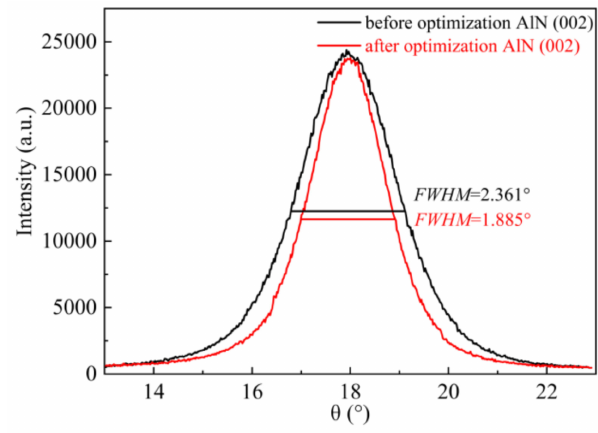
Figure 9. Swing curve of the AlN thin film.